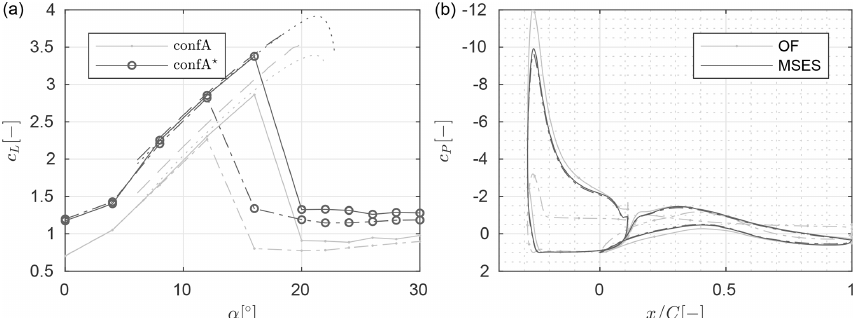
Figure 10. Performance assessment of configuration A cases optimized for maximum lift using either the auxiliary (caseA) or the integral design (caseA ∗ ) procedure. Shown in the figure are (a) the lift polar and (b) pressure distributions at α = 16 ◦ as obtained using OpenFOAM ( − clean, − . rough) and MSES ( −− clean, ·· tripped).